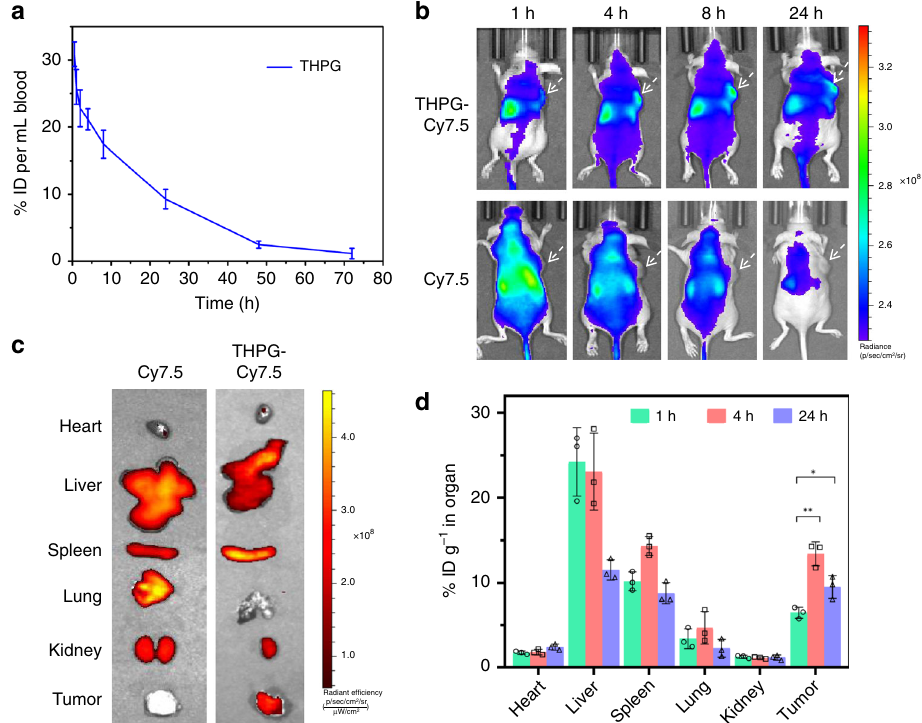
Fig. 6 The in vivo pharmacokinetic, imaging, and biodistribution studies of the THPG vesicles. a Blood clearance curve as a function of time after tail intravenous injection of THPG vesicles in rat ( n = 3 biologically independent rat) (ID stands for injected dosage). b In vivo fl uorescence images of MCF-7 tumor bearing mice with different times after intravenous injection of THPG-Cy7.5 vesicles and Cy 7.5, respectively (Ex: 745 nm, Em: 820 nm; mode: fl uorescence). White arrows were used to indicate tumors location. c Ex vivo images of isolated organs and tumors at 24 h post-injection of THPG-Cy7.5 vesicles and Cy 7.5, respectively. d Biodistribution of THPGs at 1, 4, and 24 h post-injection. ( n = 3 biologically independent mice). Data are presented as mean values + / − S.D., and P values are calculated by two-tailed Student ’ s t -test * P < 0.05, ** P <